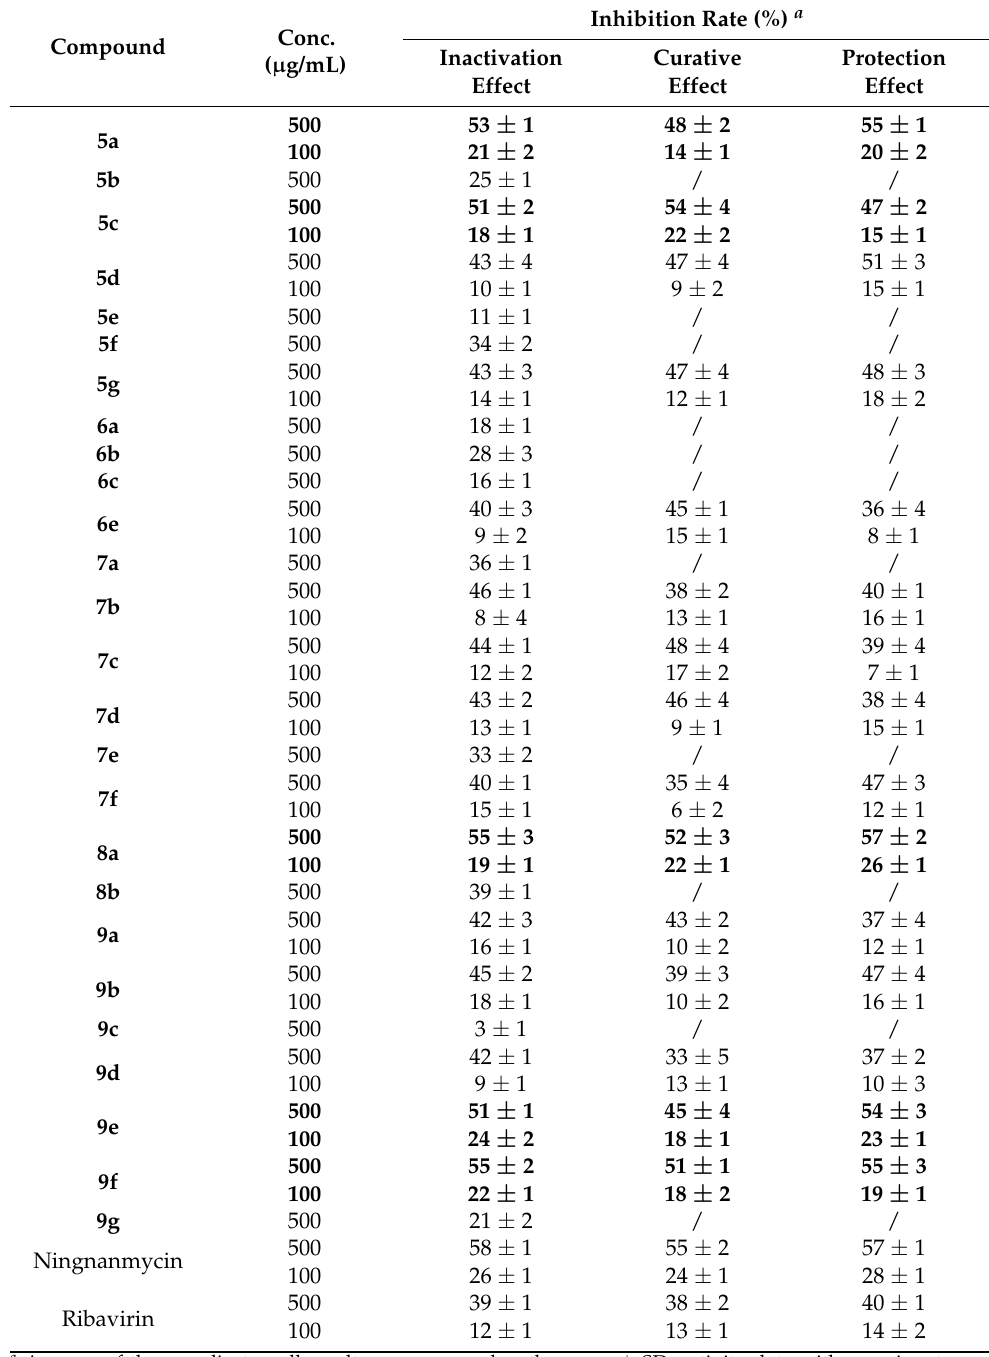
Table 1. In vivo antiviral activities of ningnanmycin, ribavirin, and compounds 5a – 5d , 6a – 6e , 7a – 7f